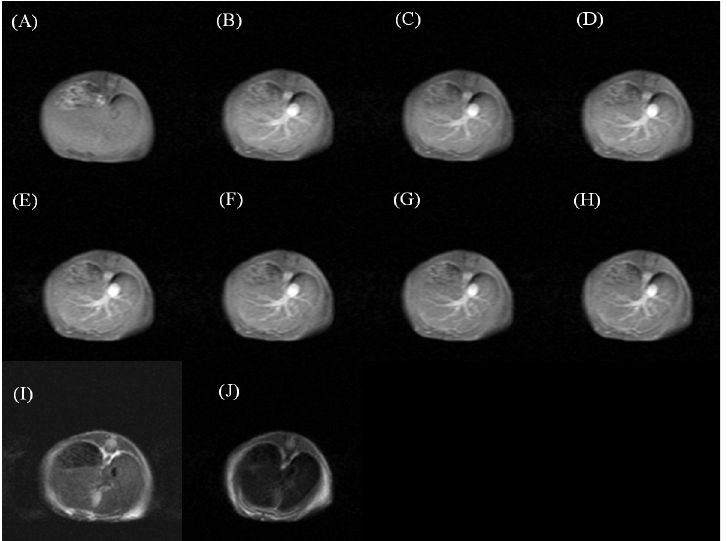
Fig 5. Dynamic contrast enhanced T1-weighted images before (A), 0.5 (B), 5 (C), 10 (D), 15 (E), 20 (F), 25 (G), and 30 (H) min after intravenous administration of Gd-MnMEIO. And T2-weighted images before (I) and 30 min after (J) Gd-MnMEIO